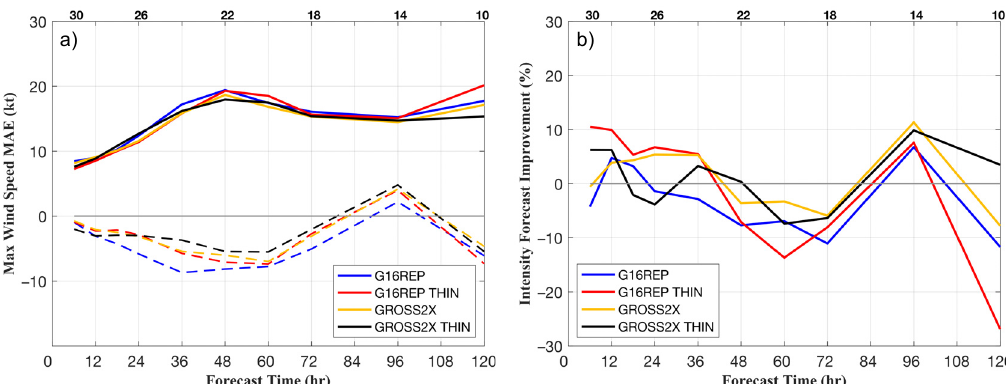
Figure 8. Hurricane Irma (2017) HWRF intensity (maximum wind speed, kt) forecast MAE (solid) and bias (dashed) verified against NHC Best Track for G16REP (blue), G16REP THIN (red), GROSS2X (gold), and GROSS2X THIN (black) in ( a ). Percentage improvement in MAE relative to BASE is shown in ( b ). The number of verifying forecasts for each lead time is shown in black across the top of each plot.